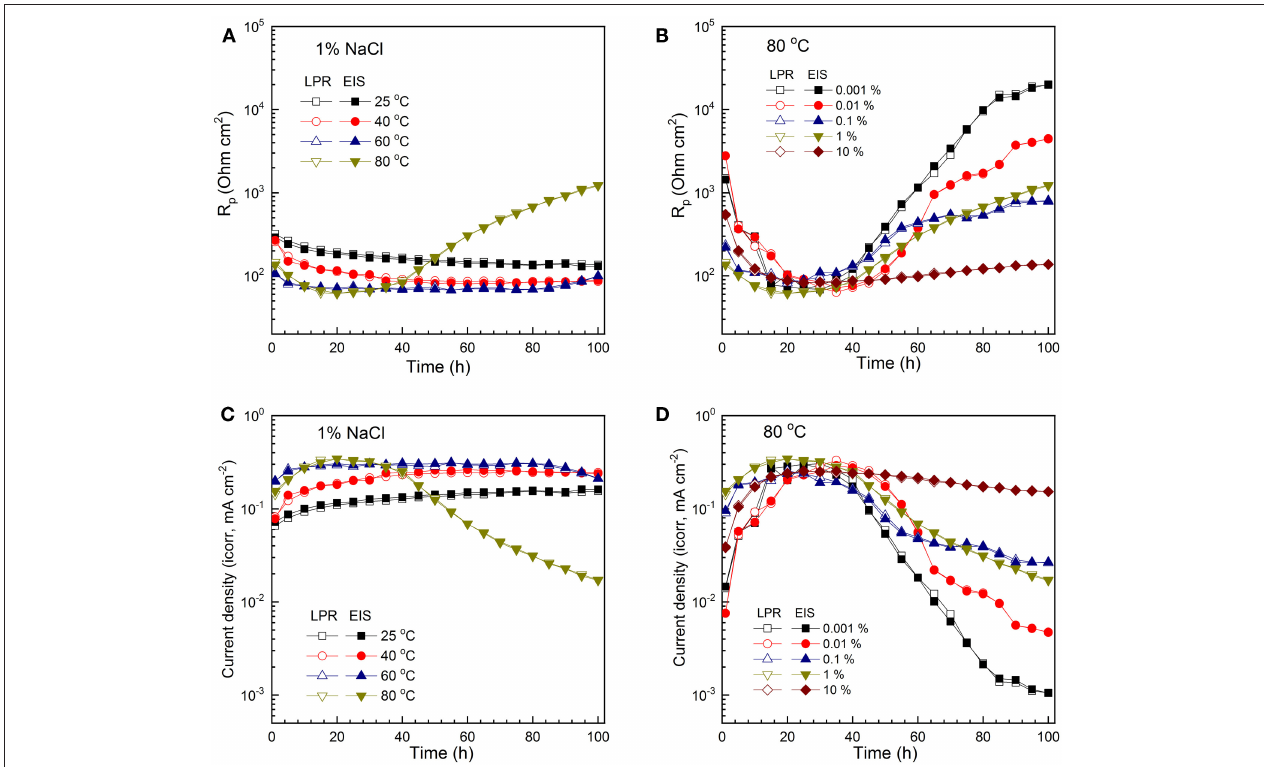
FIGURE 5 | The evolution of R p (A) and corrosion rate (C) of C1018 steel in 1% NaCl at various temperature levels, showing the effect of temperature; evolution of R p (B) and corrosion rate (D) of C1018 steel in NaCl solutions maintained at 80 ◦ C and with varying NaCl concentration, showing the effect of NaCl concentration.